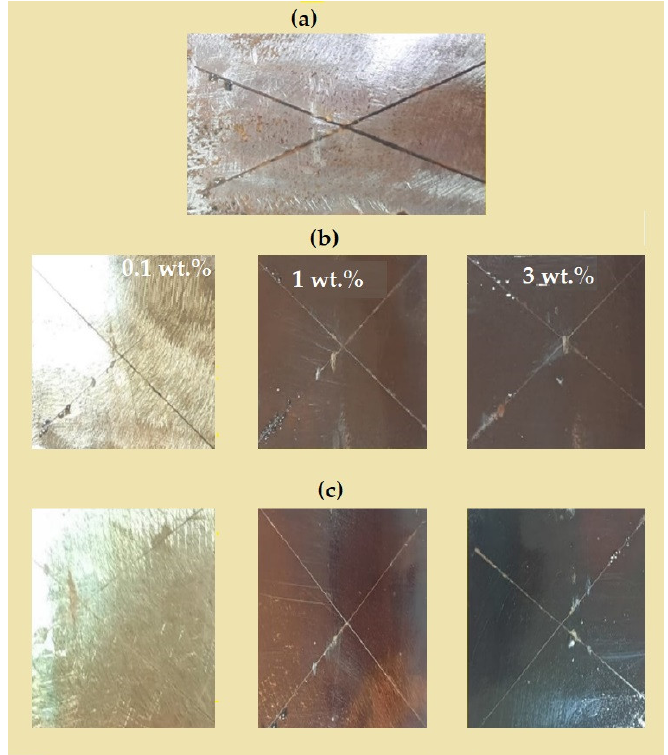
Figure 17. Salt spray resistance of the cured DGEB/ PA in the presence of different weight % of ( a ) blank, ( b ) OA-Ag and ( c ) EOA-Ag NPs.